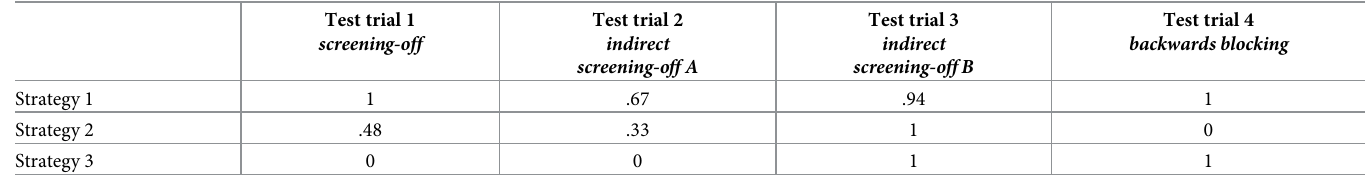
Table 2. Selected latent class model: Response